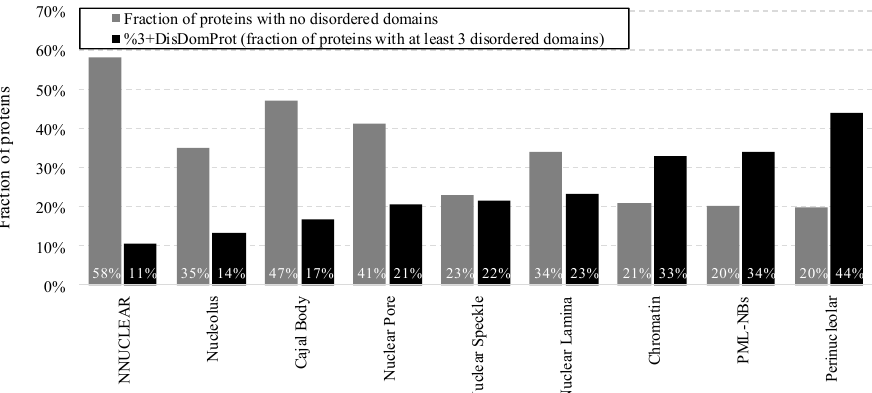
Fraction of proteins with no disordered domains %3+DisDomProt (fraction of proteins with at least 3 disordered domains)